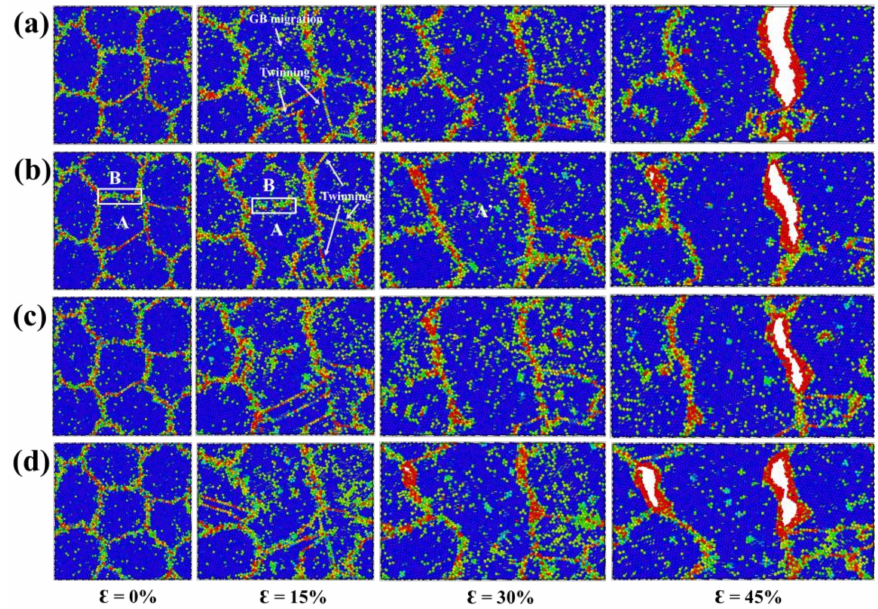
Figure 8. ( a – d ) The atomic snapshots of NG 6 at 0%, 15%, 30% and 45% tensile strains with bulk H concentrations of 0%, 0.25%, 0.5%, 0.75% and 1%,